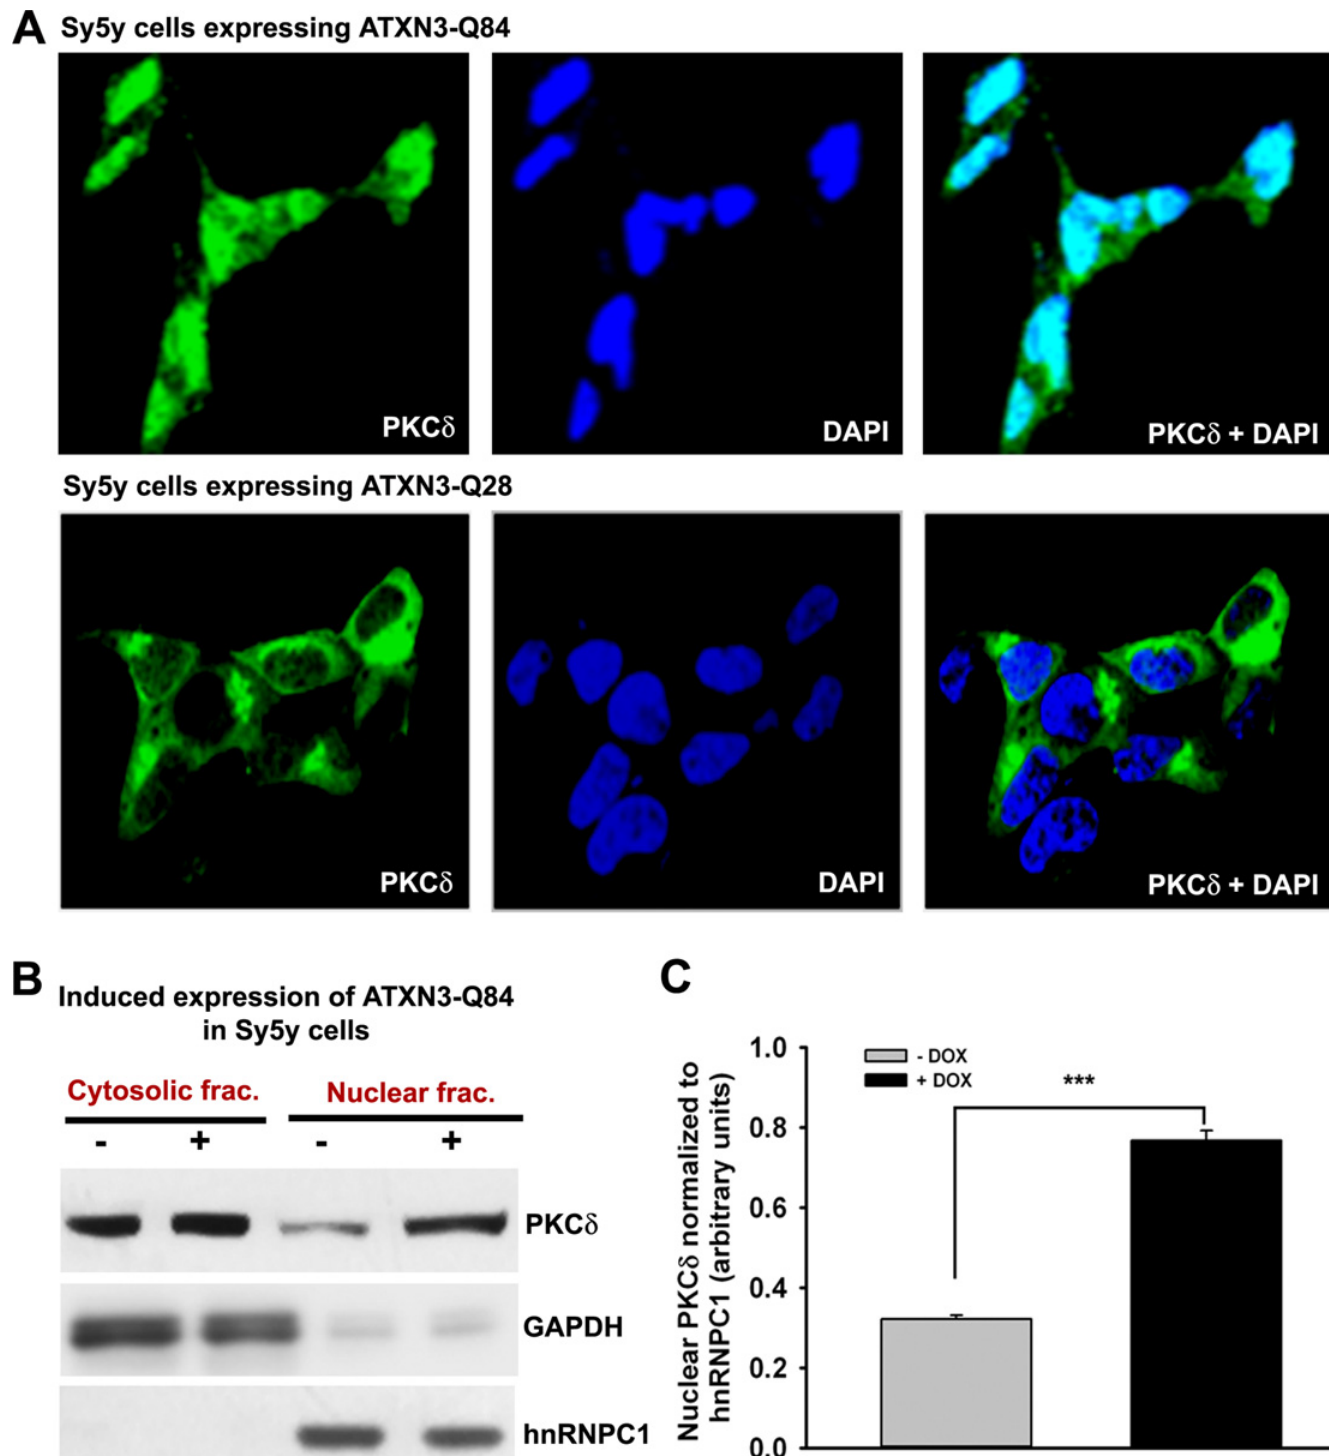
Figure 7. Expression of ATXN3-Q84 in SH-SY5Y cells facilitates nuclear translocation of PKC δ . (A) SH-SY5Y cells (2 × 10 4 cells) were plated on chamber slides, expression of ATXN3-Q84 or ATXN3-Q28 was induced, and cells were analyzed by immunostaining with anti-PKC δ antibody (green). The subcellular distribution of PKC δ was assessed by confocal microscopy; nuclei were stained with DAPI. (B) Nuclear and cytosolic protein fractions were isolated from the SH-SY5Y cells expressing ATXN3-Q84 and control un-induced SH-SY5Y cells and the protein fractions analyzed by Western blotting